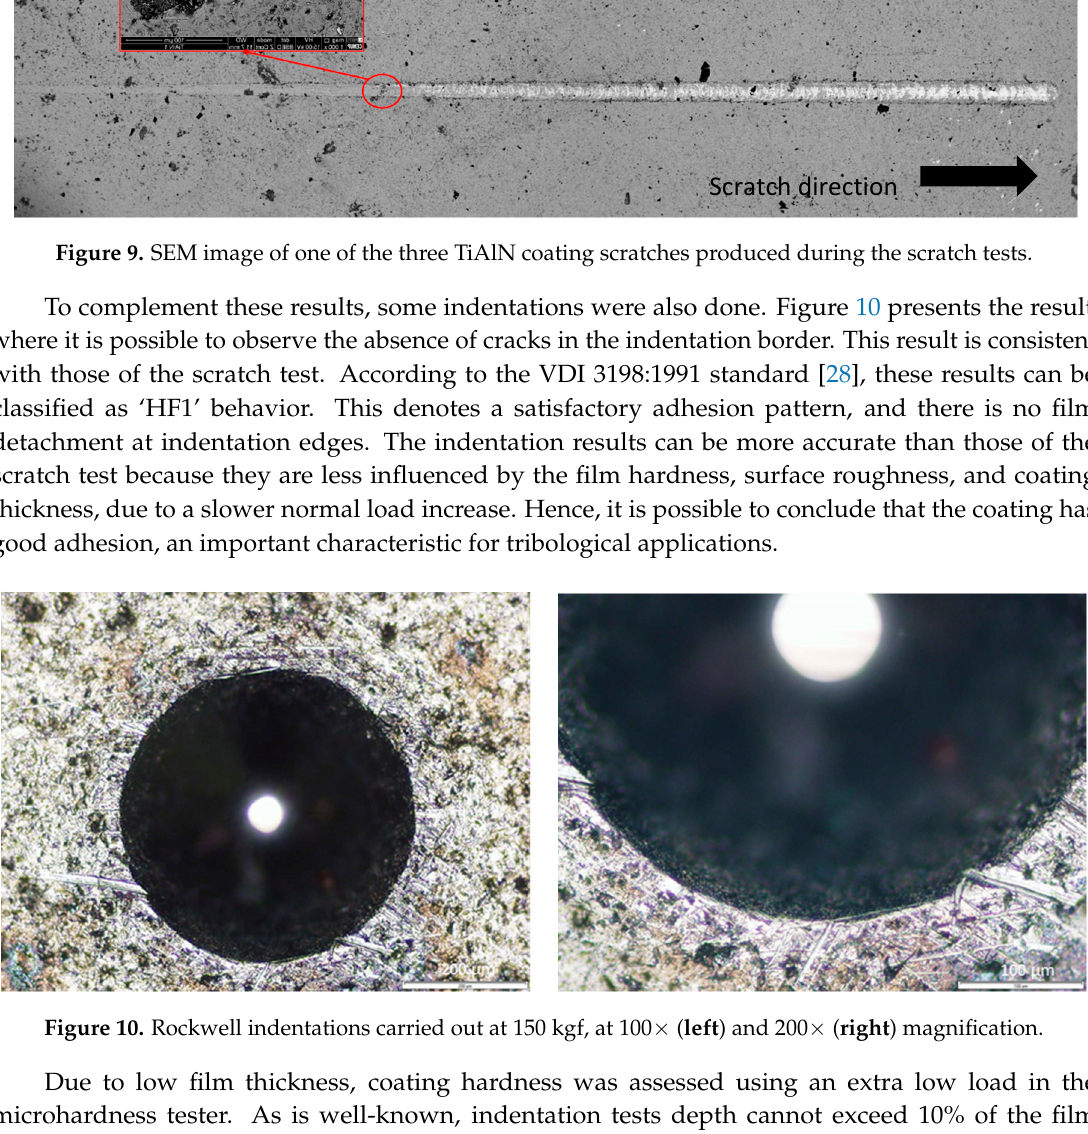
Figure 10. Rockwell indentations carried out at 150 kgf, at 100 × ( left ) and 200 × ( right ) magnification. Table 3. Ultra-microhardness and Young’s modulus of the TiAlN film.